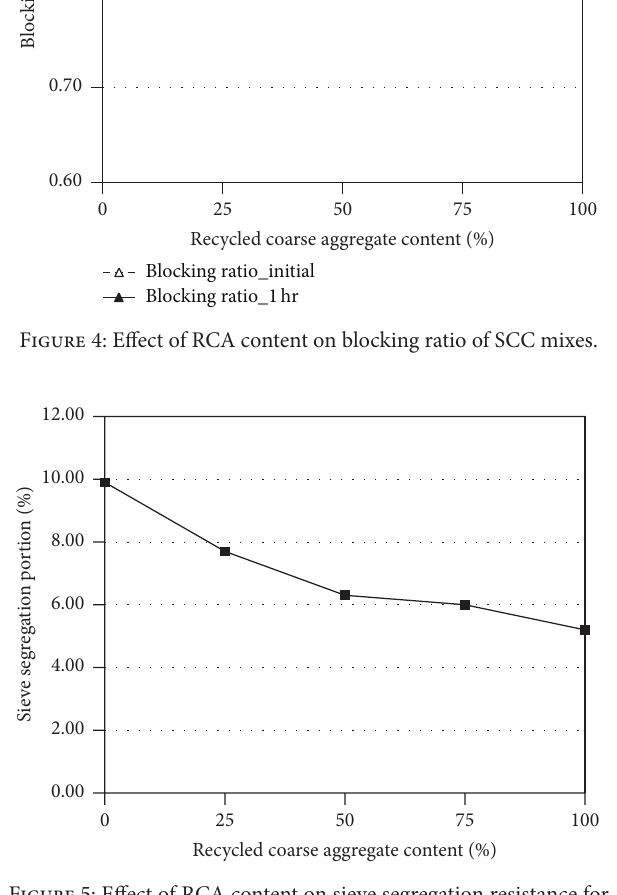
Figure 5: Effect of RCA content on sieve segregation resistance for SCC